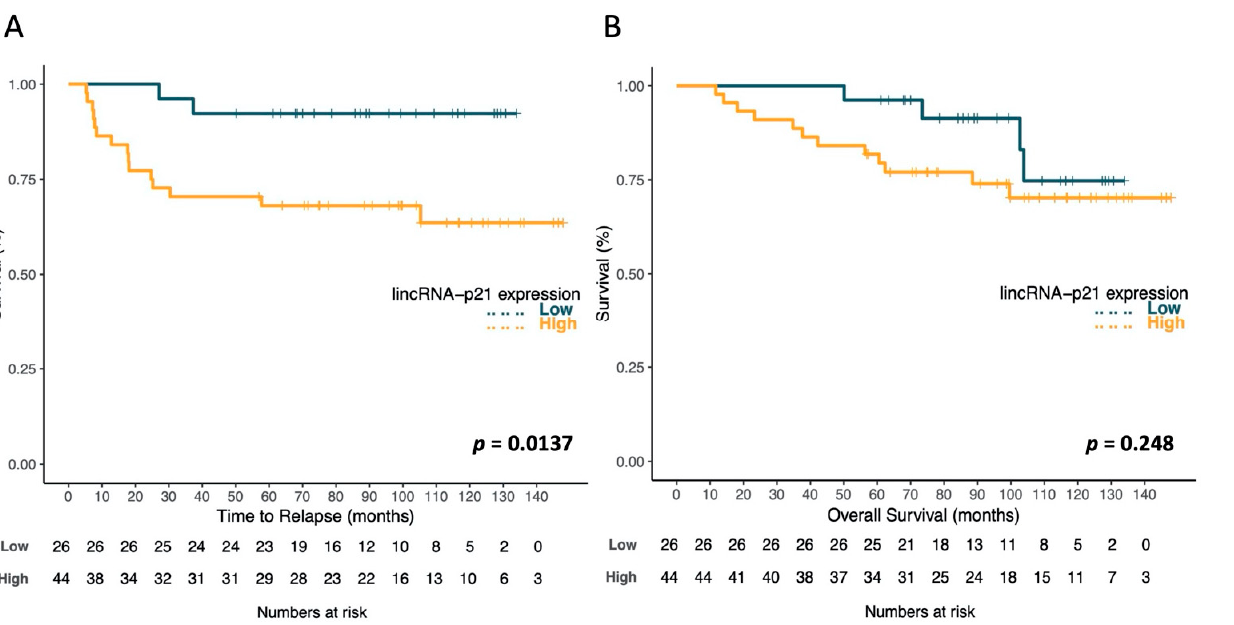
Table 3. Multivariate analysis for TTR and OS. Time to Relapse